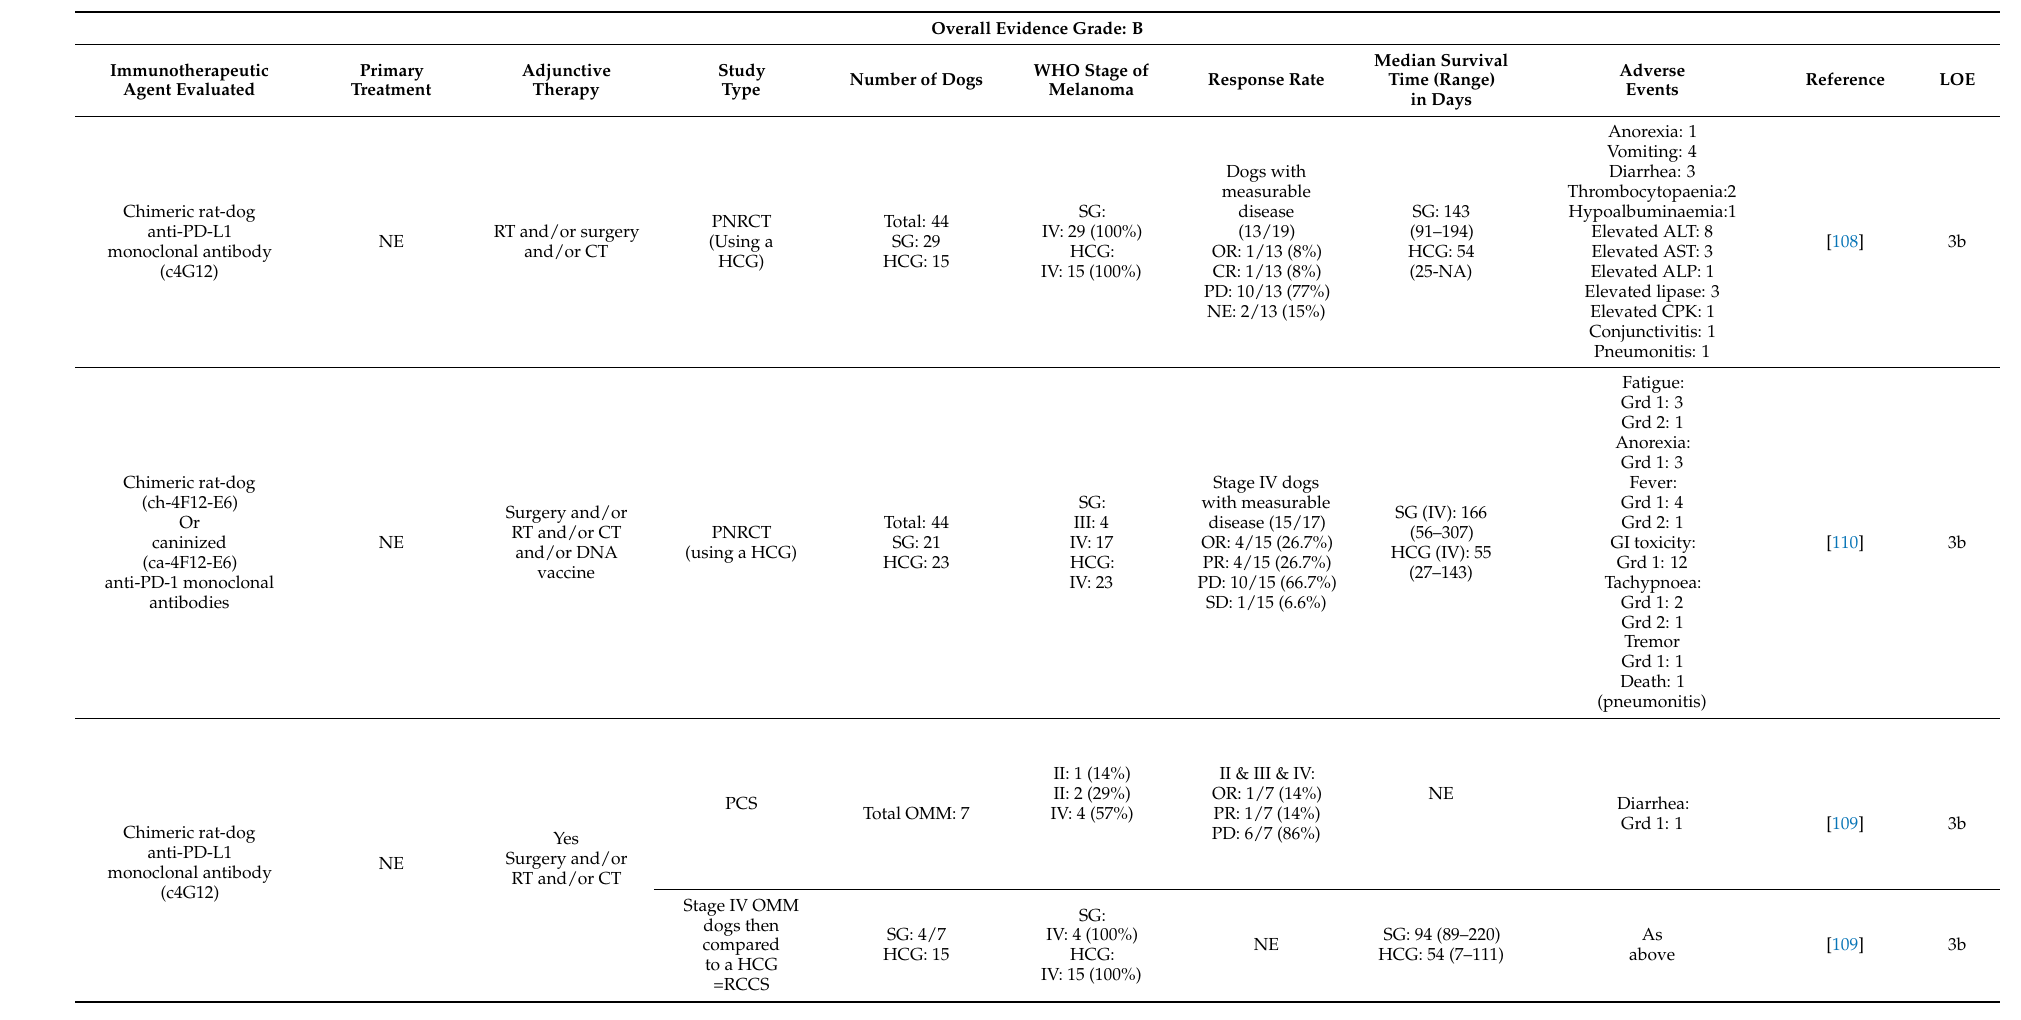
Table 14. Summary of checkpoint inhibitor studies evaluating effectivity in oral malignant melanoma. Overall Evidence Grade: